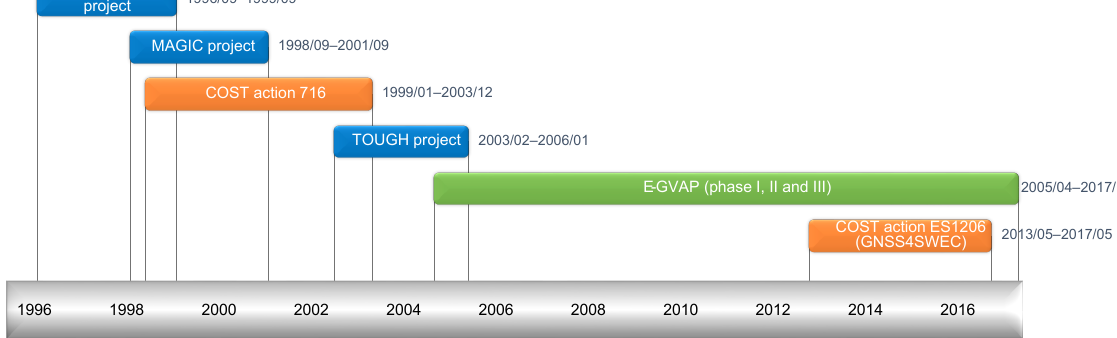
Figure 1. European GNSS meteorology projects, from 1996 to the